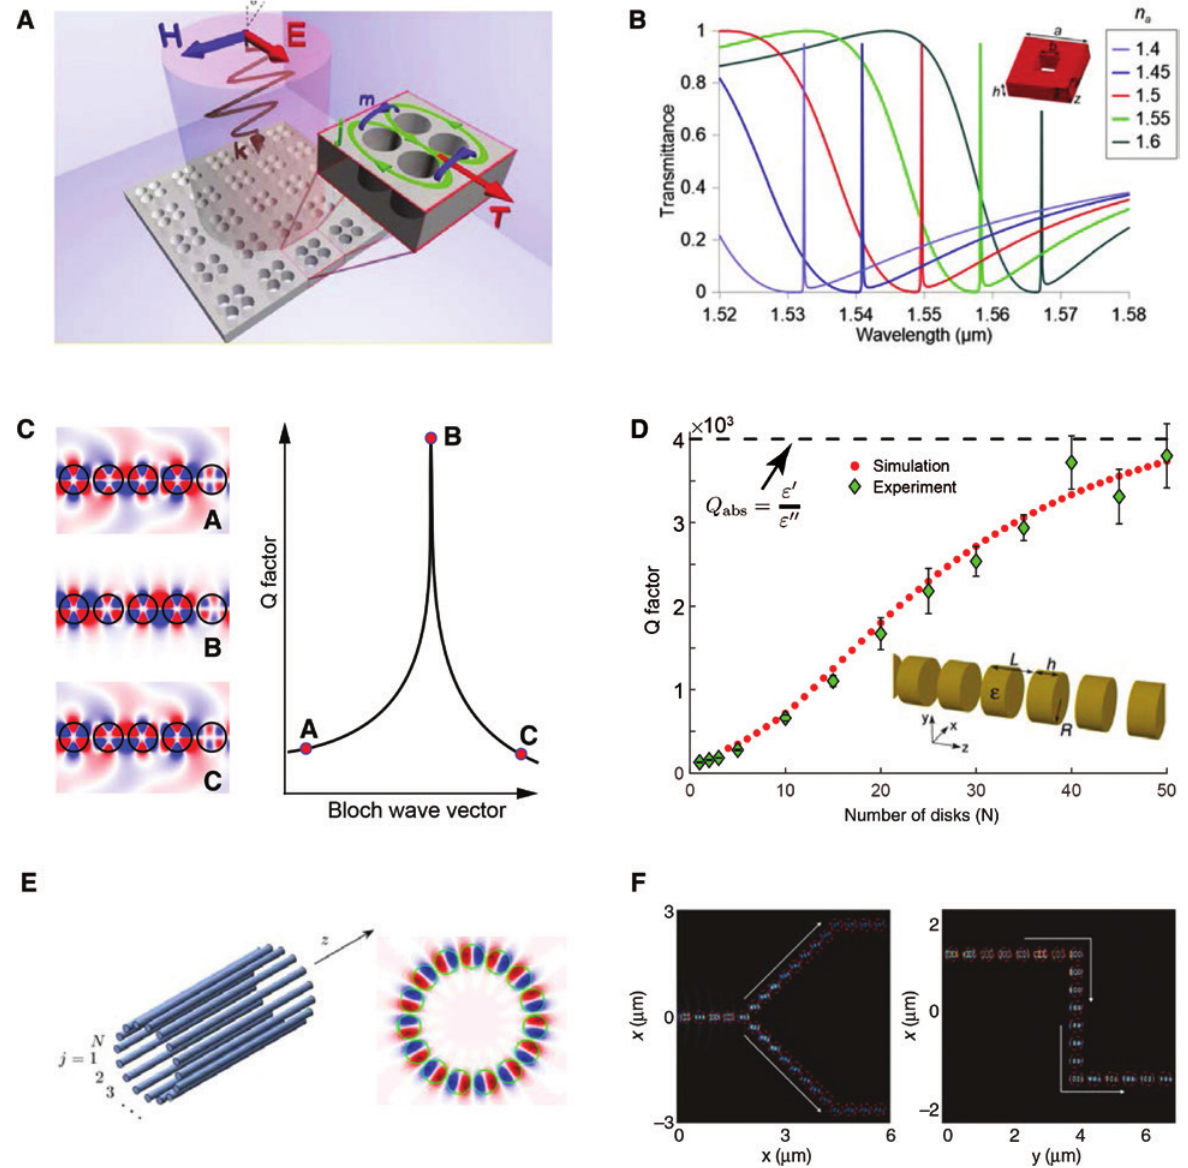
Figure 5: Anapole and BIC metasurfaces and metamaterials. (A) Illustration of the metamaterial, composed of planar 100-nm-thick Si layer with cylindrical perforations, supporting anapole modes in the near-infrared range. (B) Transmittance spectra of high-refractive-index hollow cuboid metasurface supporting anapole mode dependent on the refractive index of the analyte superstratum. The inset shows the design of the unit cell. (C) The characteristic dependence of the radiating Q factor of the leaky mode with zero orbital momentum in a chain of dielectric spheres on the Bloch wavenumber. Panels A and C show the distribution of the azimuthal component of the electric field of the leaky modes. Panel B shows the distribution of the azimuthal component of the electric field of the accidental BIC. (D) Dependence of the radiating Q factor of the symmetry-protected BIC in the chain of the ceramics disks on the number of disks. (E) Novel type of the waveguide consisting of a circular array of parallel dielectric wires providing optical signals above the light line of the surrounding space without radiation losses. (F) Dielectric disks arranged to Y-shaped splitter and S-shaped bend waveguide providing efficient transfer of anapole excitation. Adapted with permission from [38, 115, 137, 139, 140,